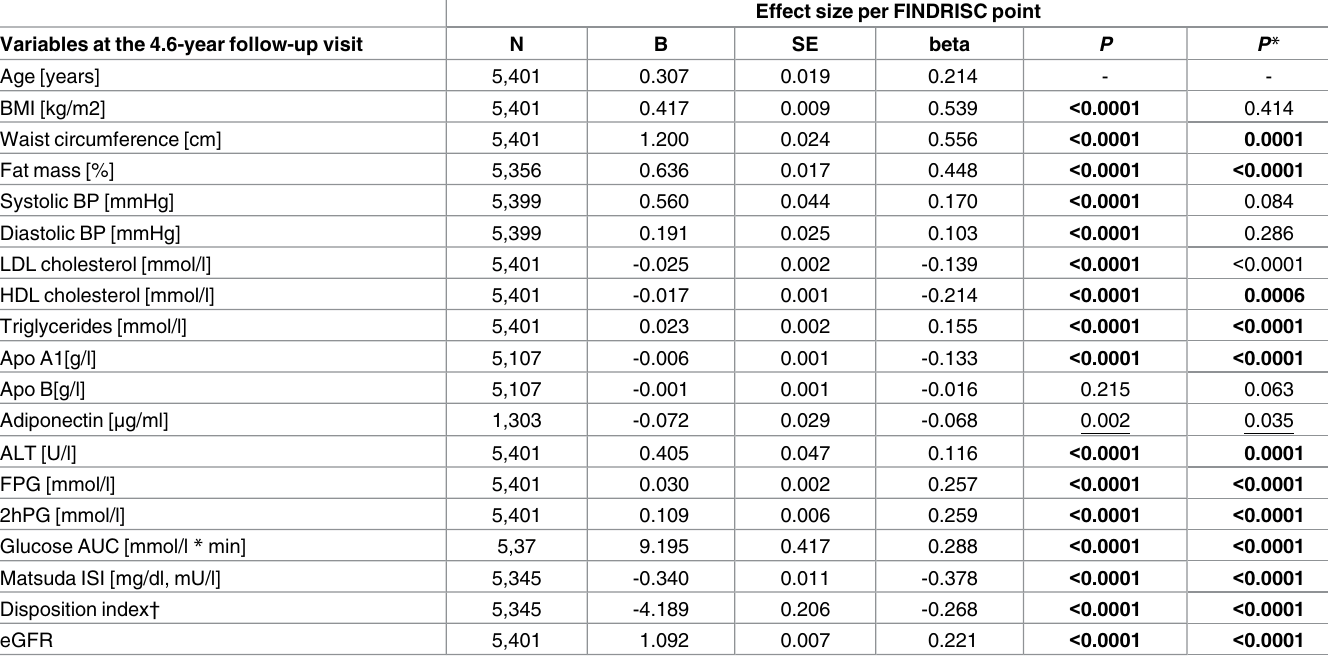
Table 2. Association of the Finnish Diabetes Risk Score (FINDRISC) with metabolic and clinical traits in 5,401 participants without diabetes or with newly diagnosed type 2 diabetes at the METSIM follow-up visit (linear regression analysis). Effect size per FINDRISC